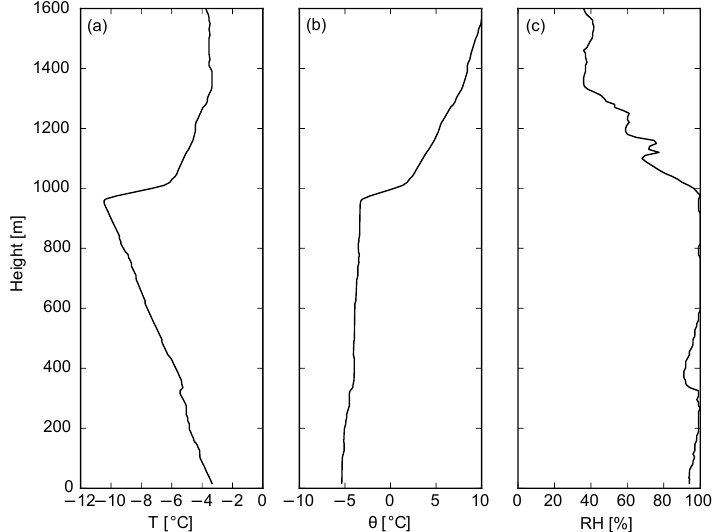
Figure 2. 31 August 05:35UTC radiosonde observations of (a) absolute temperature, (b) potential temperature, and (c) relative humidity from the ASCOS campaign. Table 2. Description of simulations performed. The last six columns indicate which models performed simulations of each case. UCL: UCLALES-SALSA, MIM: MIMICA, COL: COSMO-LES, CON: COSMO-NWP, UMC: